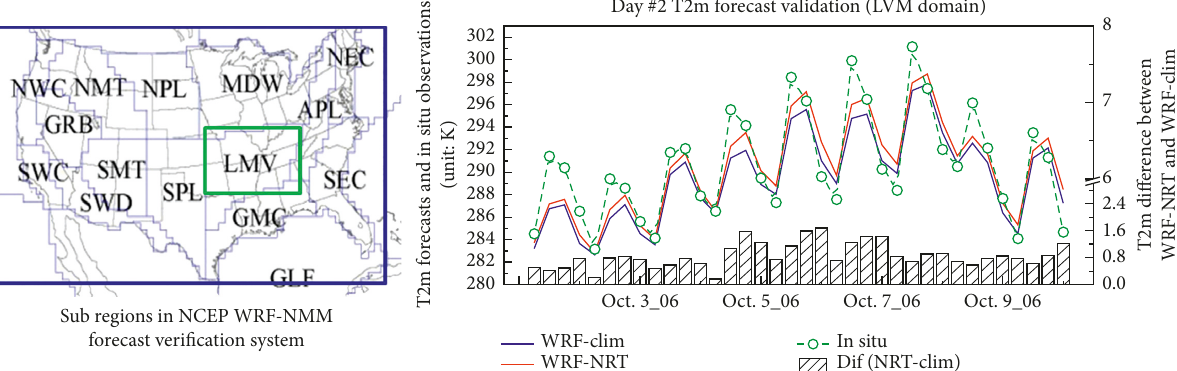
Figure 6: Forecasts of 2m surface air temperature from WRF runs (with climatology and NRT GVF) along with in situ observations, averaged from validation sites over LMV